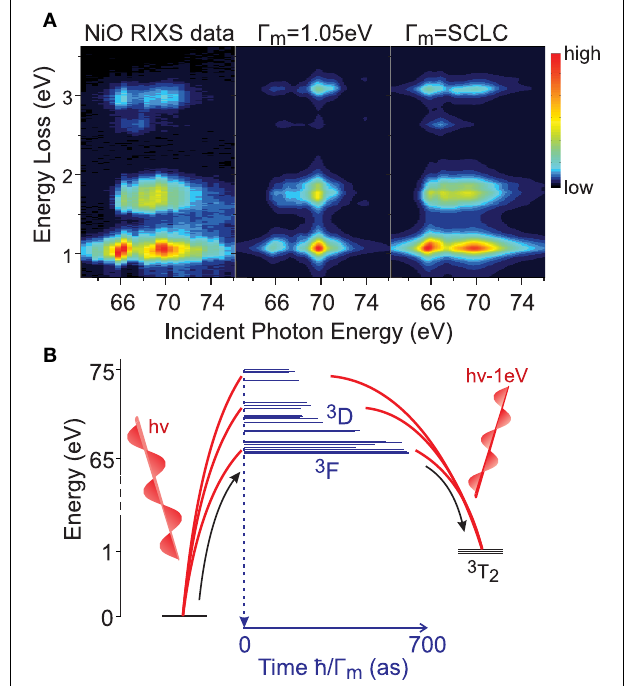
FIGURE 5 | A fingerprint of scattering dynamics. (A) (left) The incident energy dependence of NiO RIXS scattering is compared with (middle) a fixed-lifetime simulation and (right) a self consistent lifetime correction (SCLC) method [6]. (B) A diagram shows resonance pathways by which an incident photon beam can create a 1eV t 2 g to e g orbital excitation in NiO ( 3 T 2 symmetry excitation). The width of blue bars represents the calculated lifetimes of transiently occupied intermediate states. Intermediate states with significant 3 F angular momentum symmetry are clustered roughly 3–4eV below states derived from 3 D symmetry.